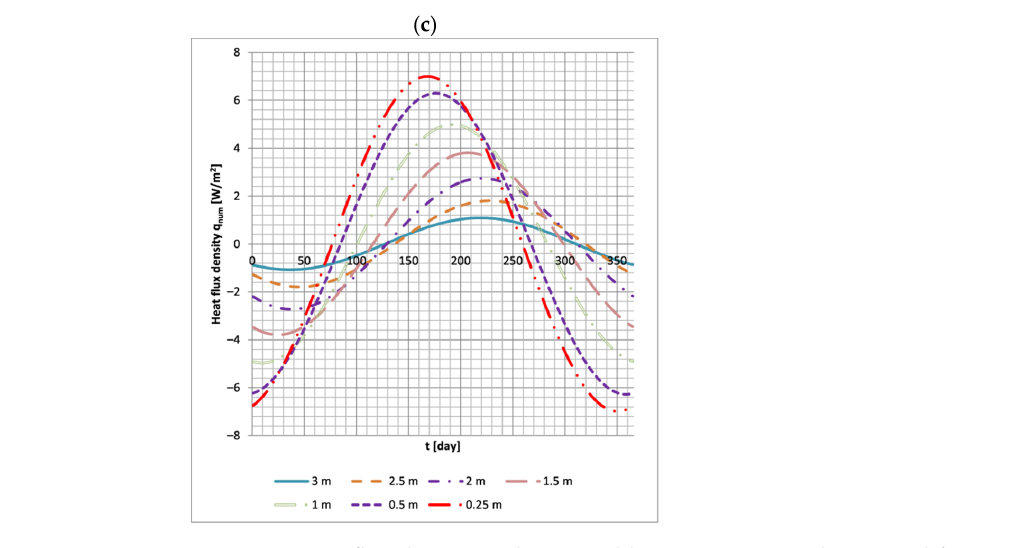
Figure 13. Heat flux density in the ground layer 0.25–3.00 m determined from Equation (9) as a function of the number of days for the three measurement points: ( a ) No. 1, ( b ) No. 2, ( c ) No. 3.